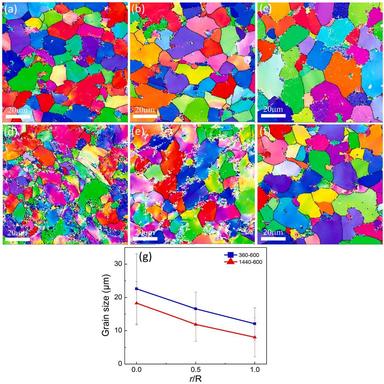
EBSD IPF pictures at different radii of (a–c) 360–600 and (d–f) 1440-600 samples, and (g) Grain size versus radius. (a,d) r = 1.0 R, (b,e) r = 0.5 R and (c,f) r = 0 R.